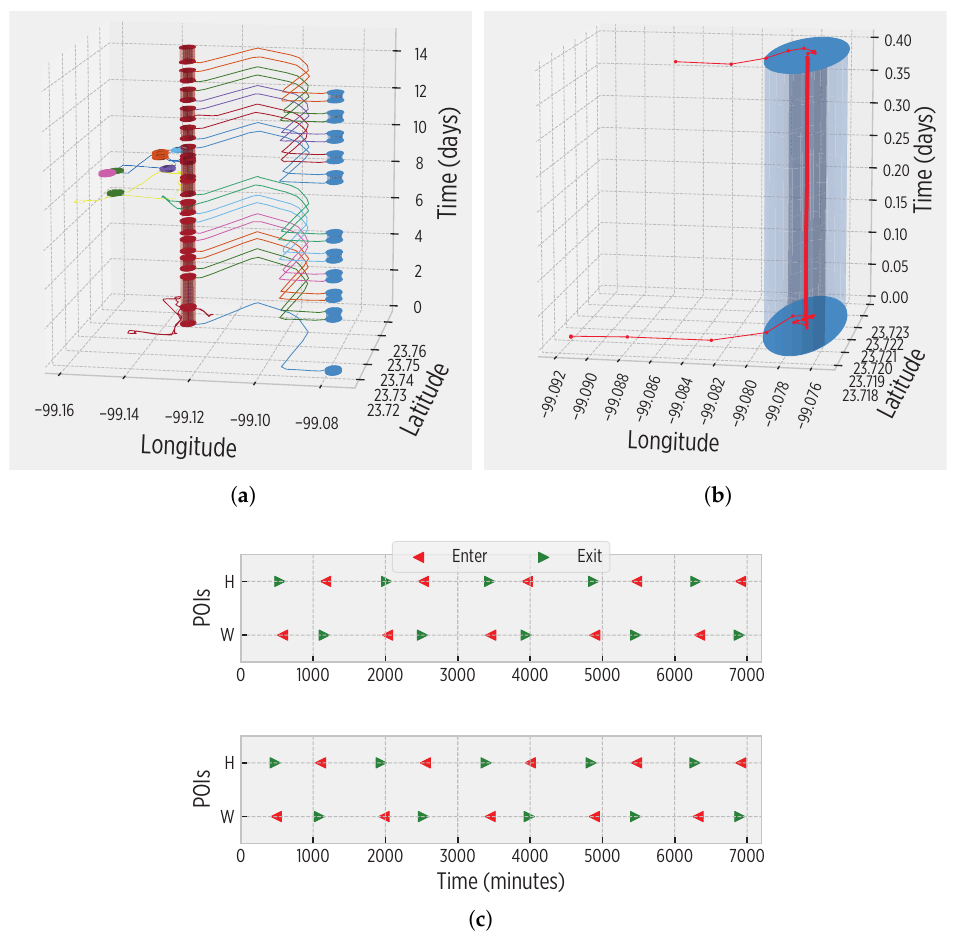
Figure 5. Spatio-temporal information autonomously derived by the system: ( a ) the cognitive map accounts for regularity, creating a summary of mobility represented in a tridimensional space; ( b ) a POI, represented by a cylinder whose height corresponds to the length of the visit; ( c ) a snapshot of enter-exit events to/from the Home (H, red) and Work (W, blue) POIs, which are dominant in typical user’s